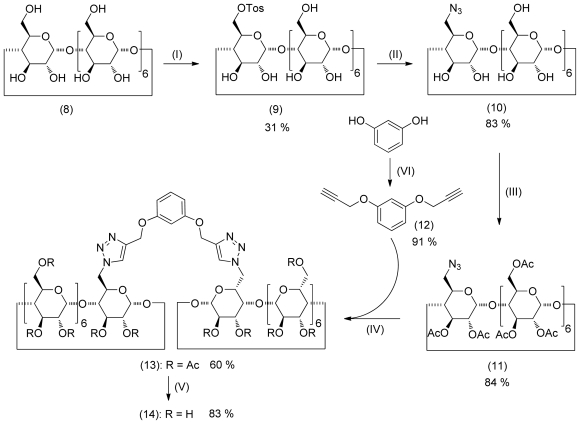
Synthesis of the cyclodextrin dimer 14. (I) TosCl, NaOH, H2O, 18 h; (II) NaN3, DMF, 60 °C, 18 h; (III) Ac2O, CH2Cl2, 12 h; (IV) CuSO4, sodium ascorbate, DMF, H2O, 18 h; (V) NaOMe, MeOH, Dowex HWCR 20, 12 h; (VI) BrCH2CCH, K2CO3, acetone, 18 h.